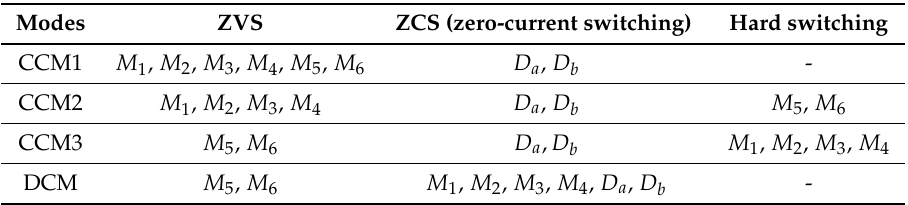
Table 1. Soft switching conditions for different operation modes.